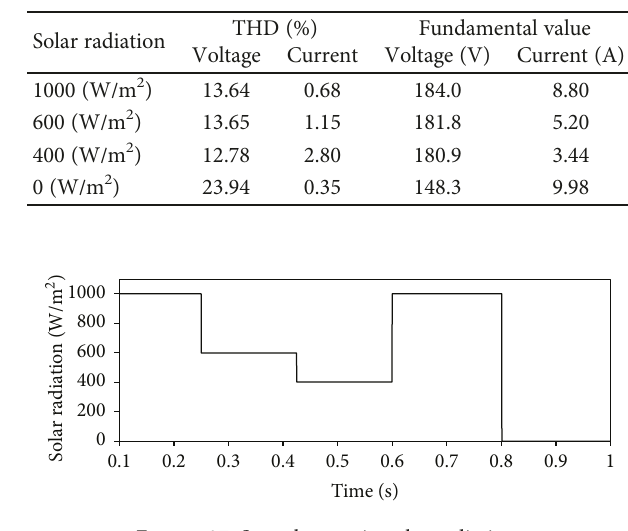
Figure 27: Step changes in solar radiation.